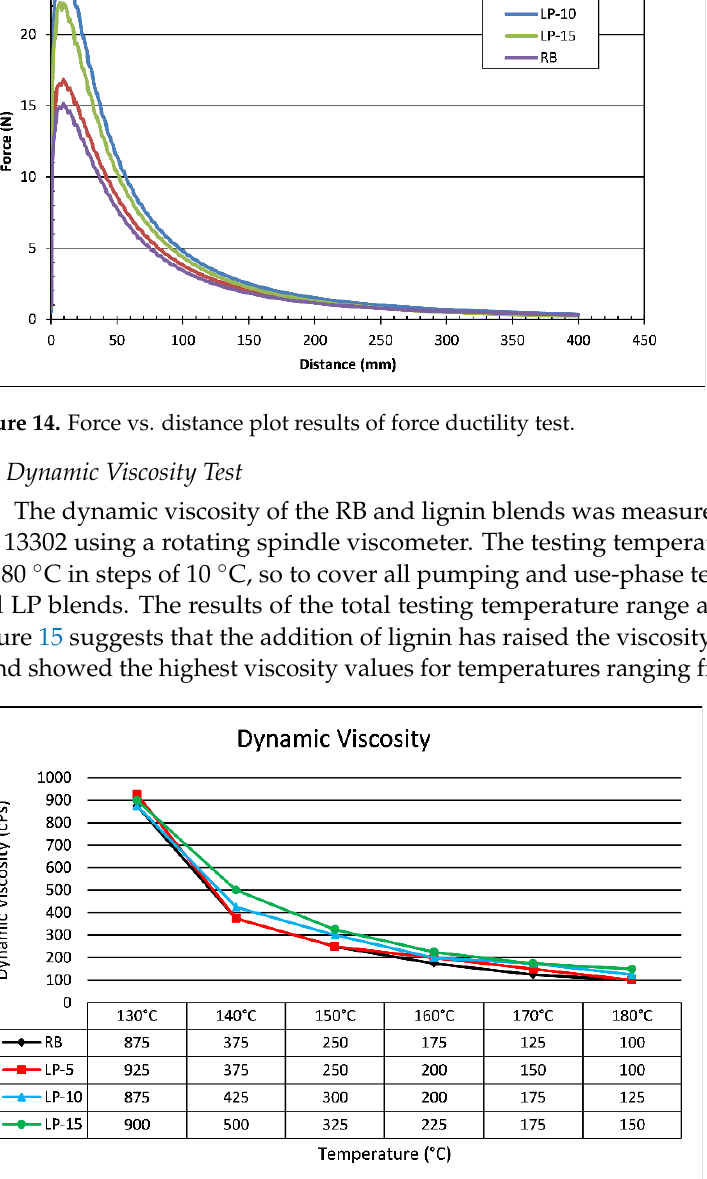
Table 6. Storage stability results.